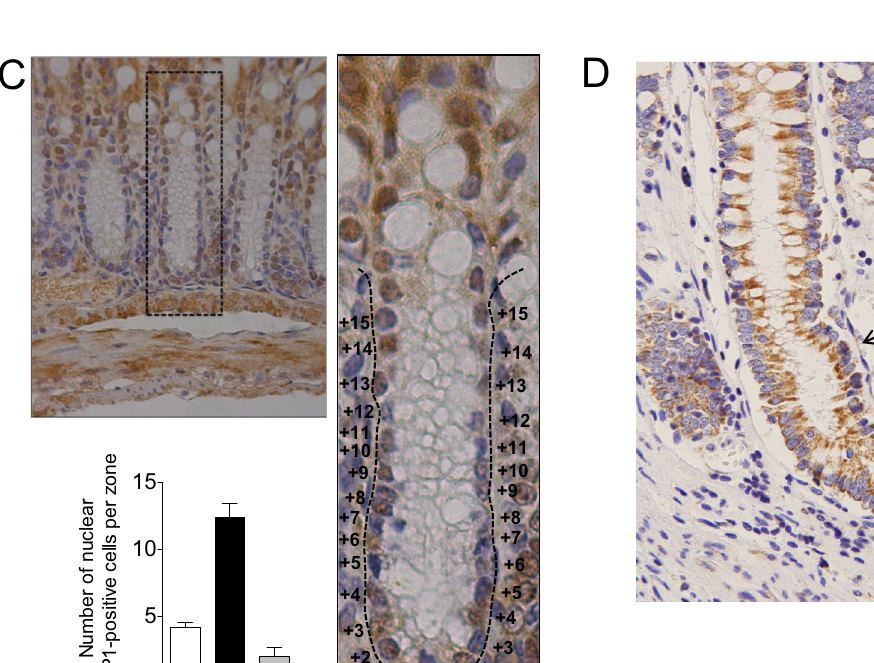
Figure 1. Lonp1 localizes in the nuclei of mouse colon tissue and human colon tissue. ( A ) Representative images of Lonp1 IHC on murine colon tissue, showing Lonp1 nuclear localization. ( B ) Representative images of Lonp1 IF on murine colon tissue, showing Lonp1 nuclear localization. Nuclei were counterstained with DAPI. ( C ) Representative Ki-67 IHC staining in intestinal crypt. Cells of the crypt were sectioned into three zones: the lower (0 to + 4), upper (+ 5 to + 15), and non (> + 15)-crypt zones. The histogram represents the percentage of cells with nuclear Lonp1 per crypt zone (n = 10 crypts per group). Data represent the mean ± SD. ( D ) Representative images of Lonp1 IHC on human colon tissue, showing Lonp1 nuclear localization (arrows). Bar: 200